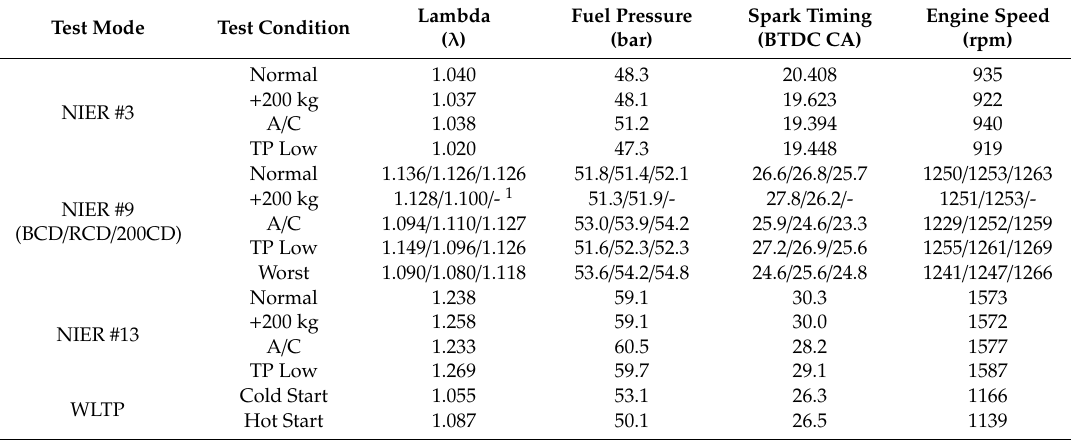
Table 4. Averaged engine operating